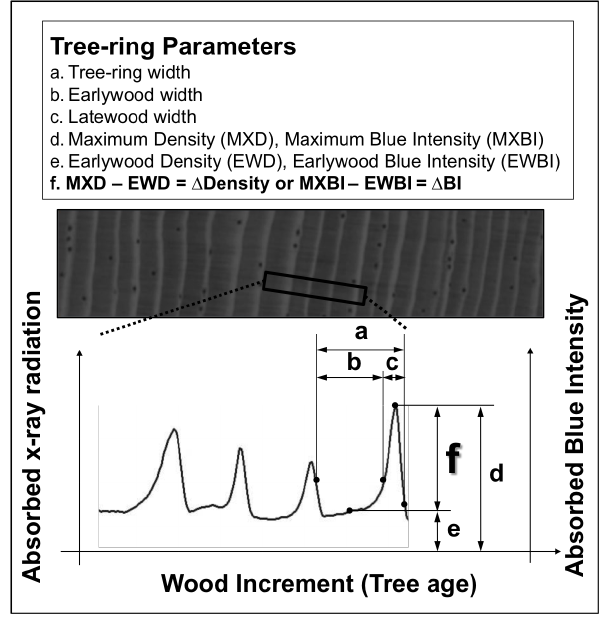
the relation of the new previously unexploited 1 density- and 1 BI- parameters to the more familiar parameters TRW, MXD, etc. Note that the blue intensity parameters are using the radiographic image, which is essentially similar to an optically scanned